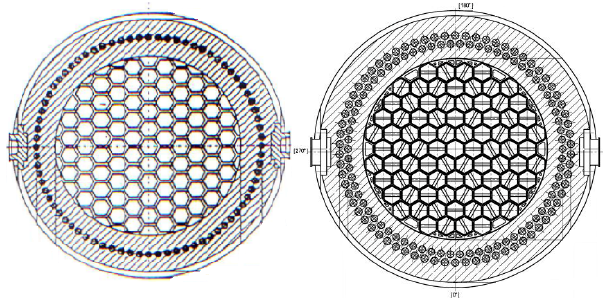
Figure 3. Plain cut in the dual purpose storage and transportation casks CASTOR 440/84 (left) and CASTOR 440/84M (right)